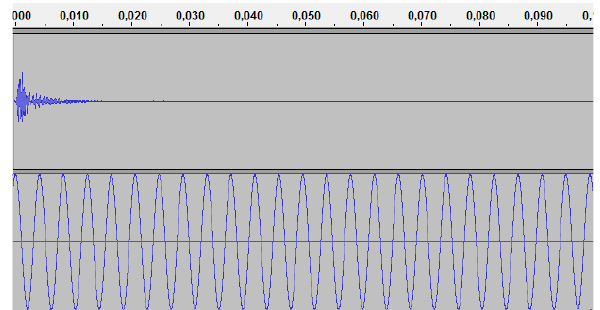
Figure 2. Signal waveforms of auditory (on the top) and haptic (on the bottom)